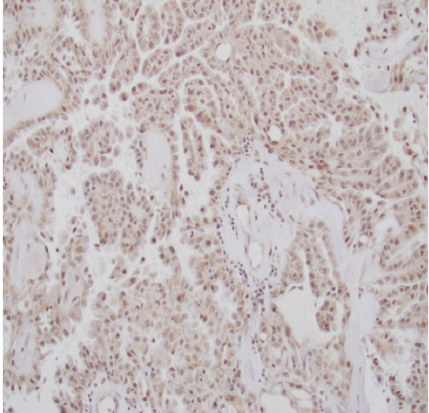
Figure 9: Diffuse nuclear positivity to INI-1 immunostain.